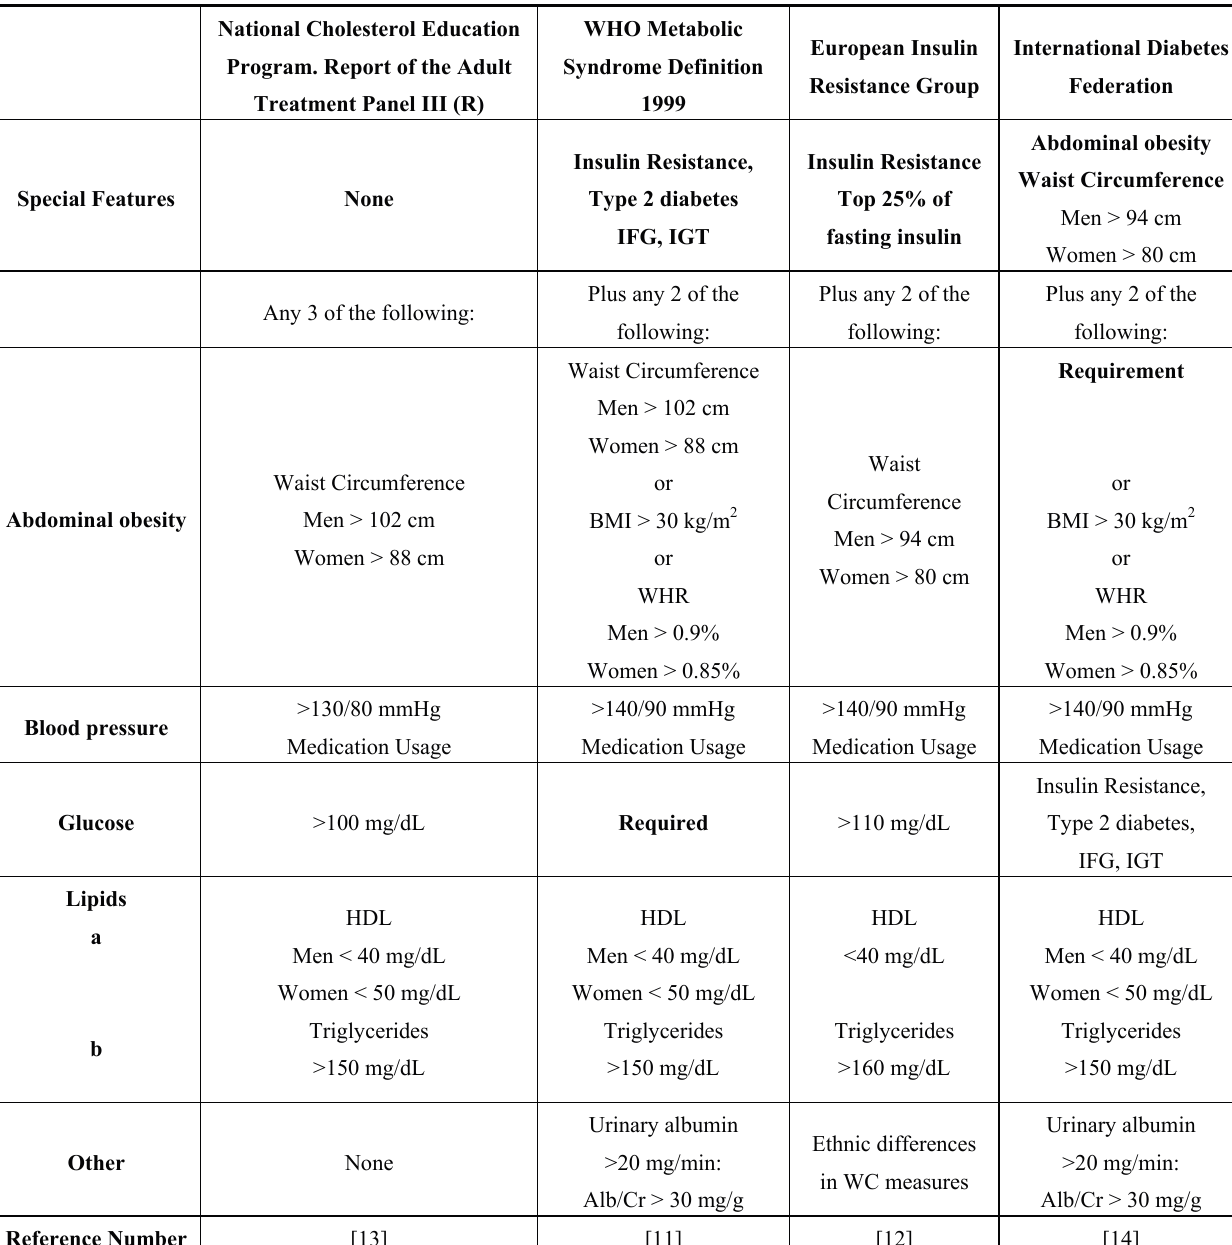
Table 1. Definitions of metabolic syndrome by various